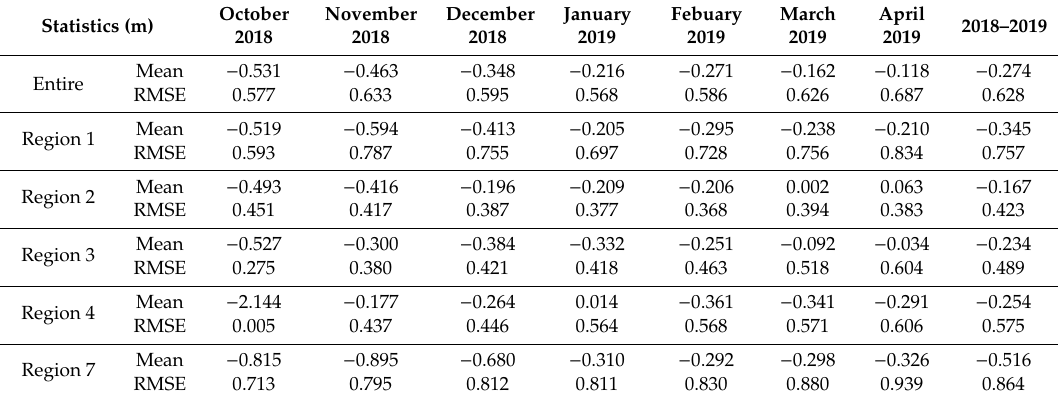
Table 5. Statistics of the sea ice thickness bias between the LSA and the NASA Goddard Space Flight Centre